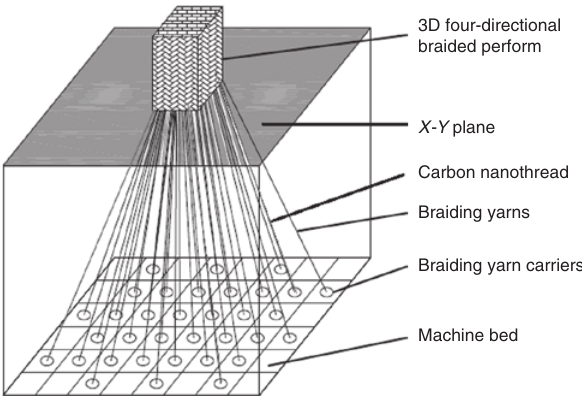
Figure 1: Schematic setup for the four-step 1 × 1 braiding